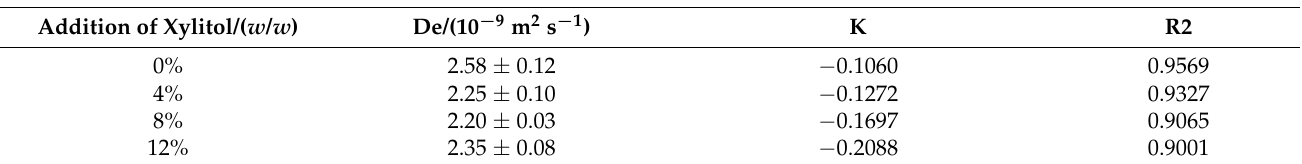
Table 1. Kinetic parameters and fitting correlation coefficients of pork tenderloin cured in different xylitol